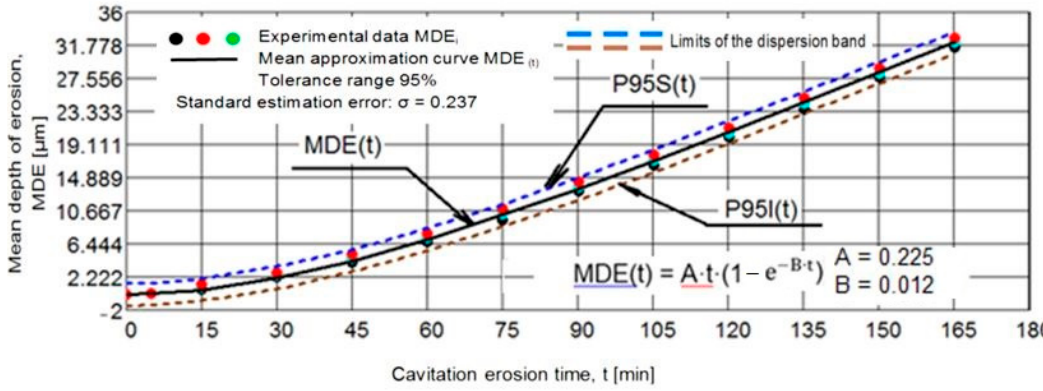
Figure 5. The dispersion range of the experimental values for the samples subjected to solution hardening solution. Statistical reference parameters of the dispersion band. Figure 6. The dispersion range of the experimental values for the nitrided samples. Statistical refer- ence parameters of the dispersion band.